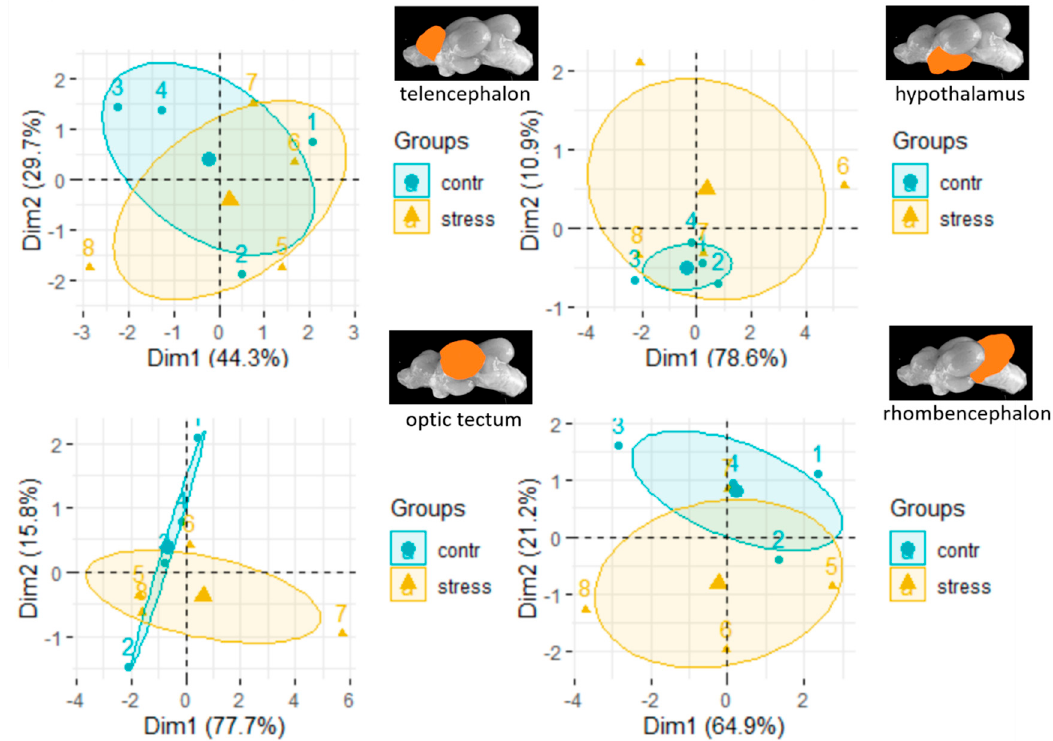
Figure 5. Results for the first two components (Dim1 and Dim2) of the principal component analysis (PCA), including confidence ellipses for the selected genes gabaa , crfr1 , crfr2 , erg-1 , mr , erg-1 , 5-ht-r and c-fos in each in the four brain parts of control fish and fish 30 min after the air exposure (the numbers in the brackets indicate the percentage of the variance in the data sets that is explained by each components, mean ± SEM; n = 4 per treatment.